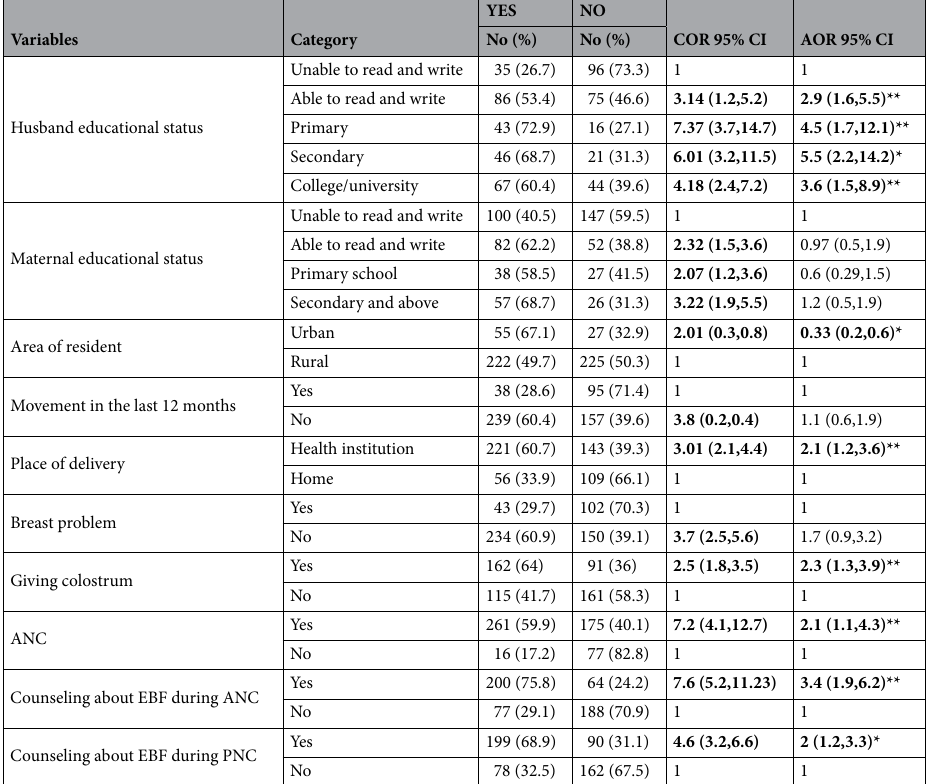
Table 4. Factors associated with practice EBF among mothers of children aged between 6 and 12 months during multivariable logistic regression analyses in Cherti district, Afder zone, Somali Region, southeastern Ethiopia, 2019, (n = 529). Significant values are in